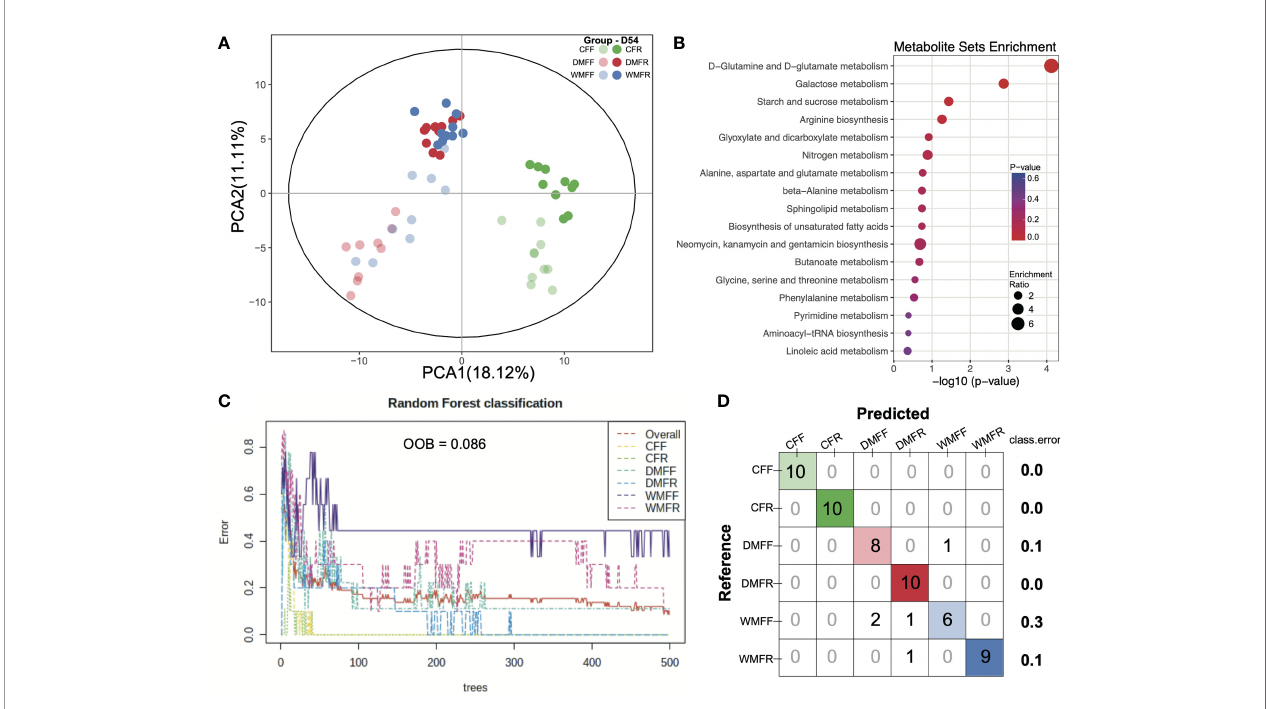
FIGURE 5 | Metabolism in the gut in mice treated with fecal microbiota transplantation (FMT) together with dietary fi ber intervention at day 54. (A) Principal component analysis (PCA) revealed the pro fi les of metabolites in the gut of mice within the six groups. (B) Enrichment pathways for the differential metabolites in the gut. (C, D) Random forest model was constructed, and a confusion matrix was applied with the dataset of metabolites in the gut of